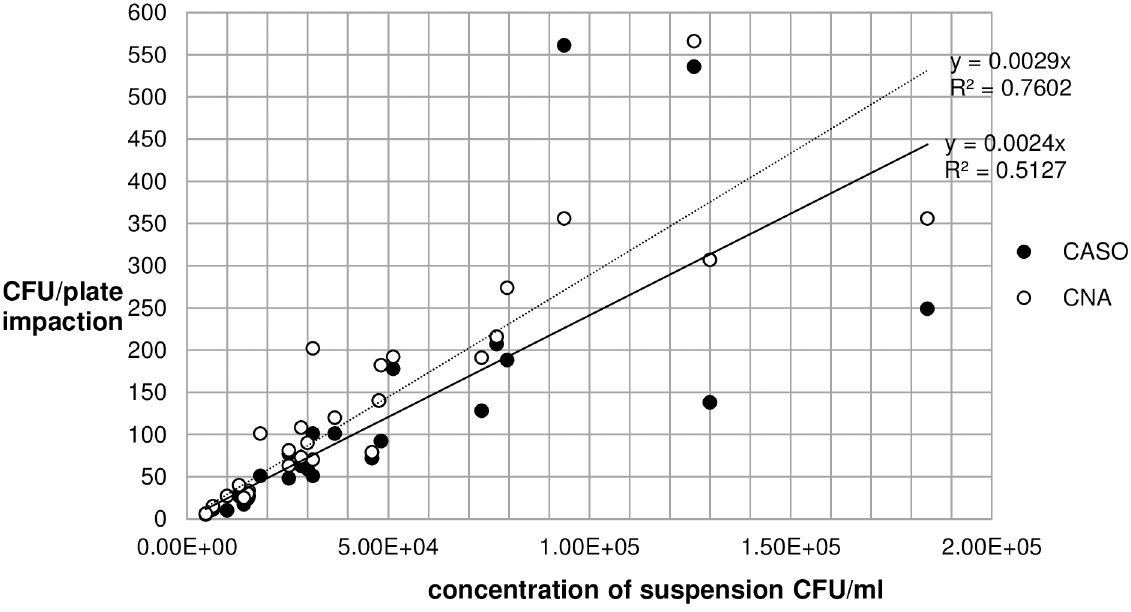
Fig 4. Comparison between CASO- and CNA-agar impaction for S . aureus